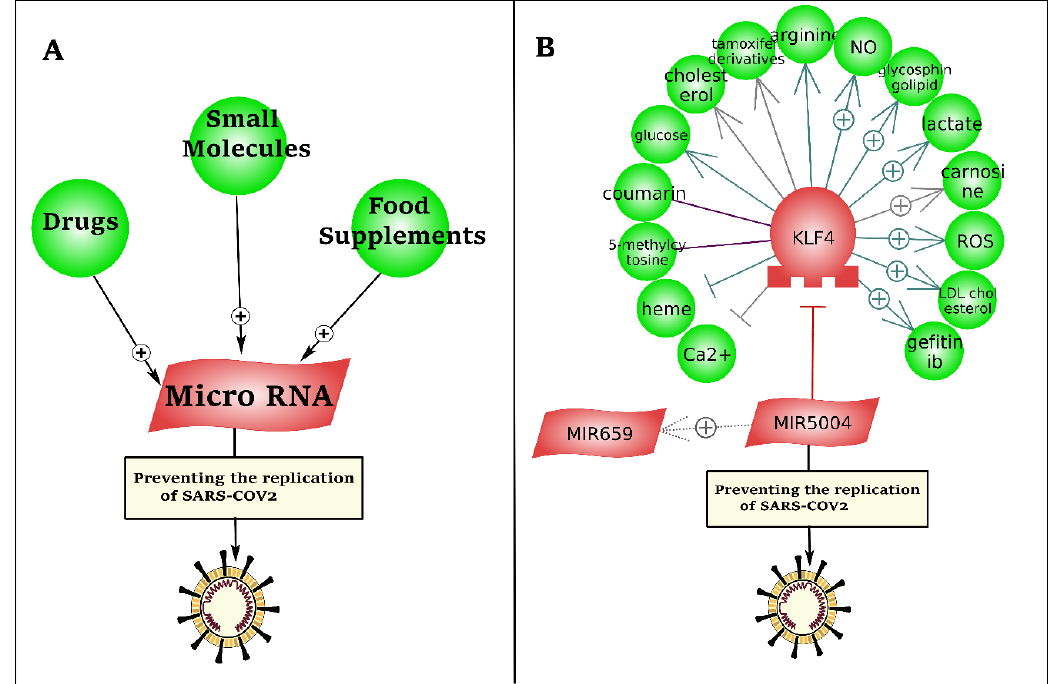
Figure 7. Drug repurposing to induce inhibitory microRNAs against the leader sequence and TRS of the 5’UTR region of SARS − CoV − 2. ( A ) The presented pipeline of literature mining − based drug discovery. ( B ) Upregulation of hsa-miR-5004-3p has potential to prevent SARS − CoV − 2 replication via binding to the leader sequence in the 5’UTR of virus.